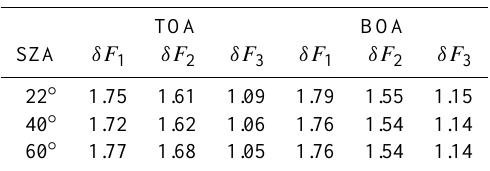
Table 2. δF as in Table 1 at TOA and BOA at a location 45 ◦ N 12 ◦ E for three different